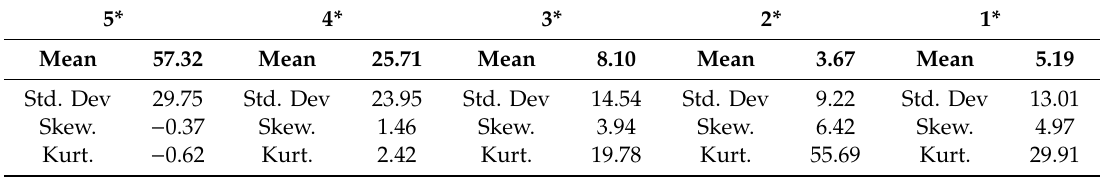
Table 9. Descriptive statistics of % of reviews out of total restaurant reviews per score